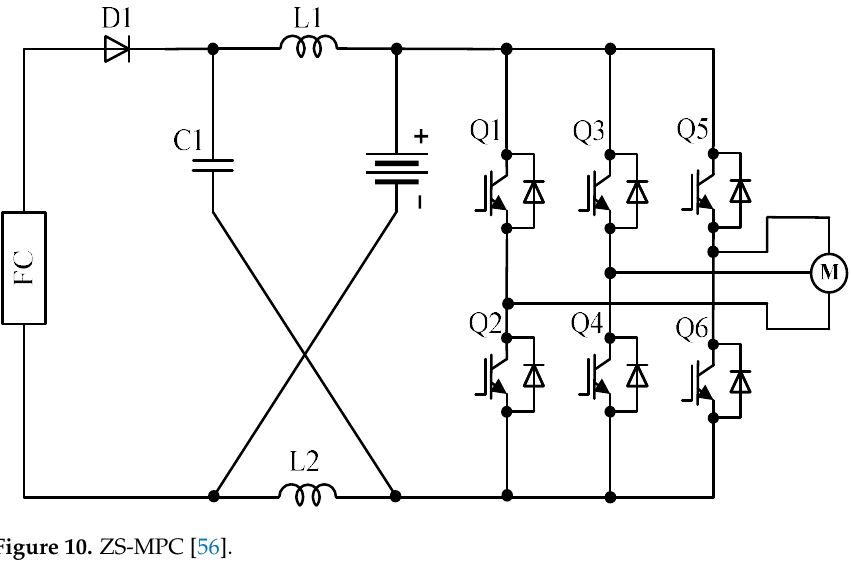
9 of 16 Figure 9. Diode-Clamped Multi-Port Converter [51]. 5.4. Z-Source Based Multi-Port Converters (ZS-MPC) The Z-Source Converter (ZSC) is a single-stage buck-boost converter with two independent control freedoms, a modulation index that controls the output of the ZSC, and a shoot-through to boost the dc-link voltage [52,53]. The quasi-Z-Source Converter (qZSC) is created from the Z-source converter and, as well as all the benefits of the ZSC for application in a RES system, it has continuous input current. Many different solutions